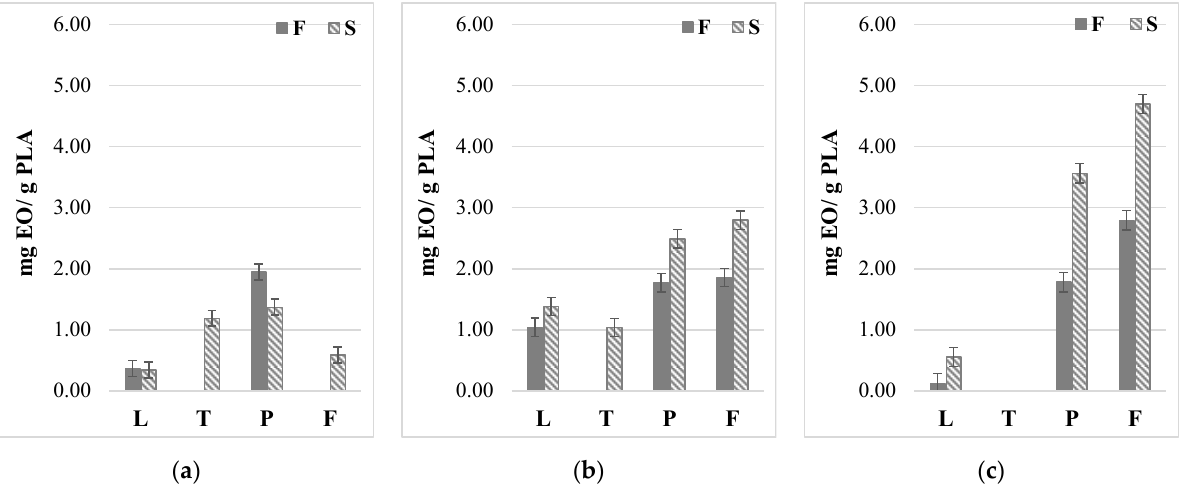
Figure 5. The specific amount of essential oil in methanol solutions at different concentrations: ( a ) 1 wt.% solution; ( b ) 1.5 wt.% solutions; ( c ) 2 wt.% solutions.